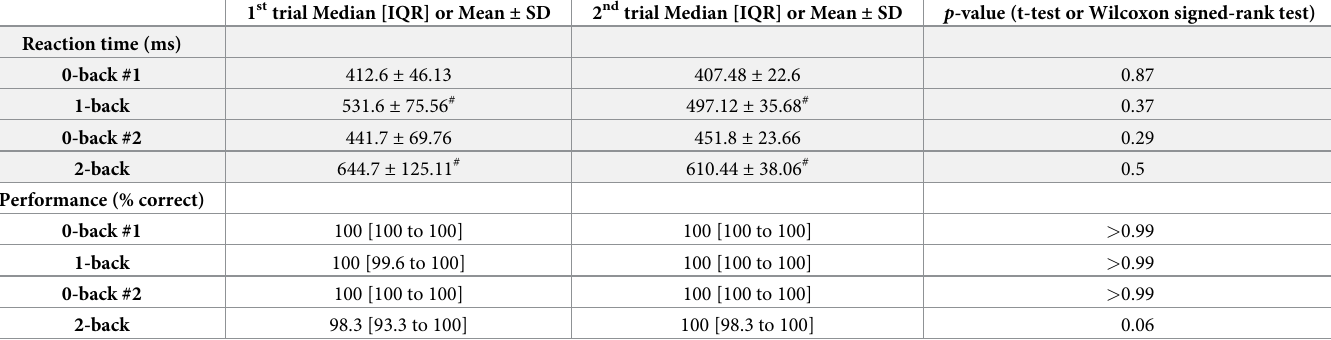
Table 1. Cognitive performance in the group of healthy young adults and the practice effect of the repeated n -back